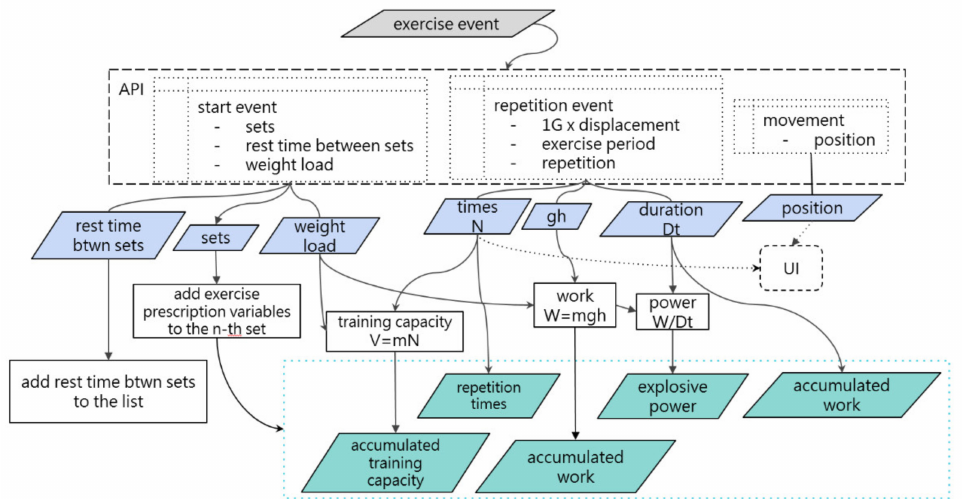
Figure 8. Exercise event handler